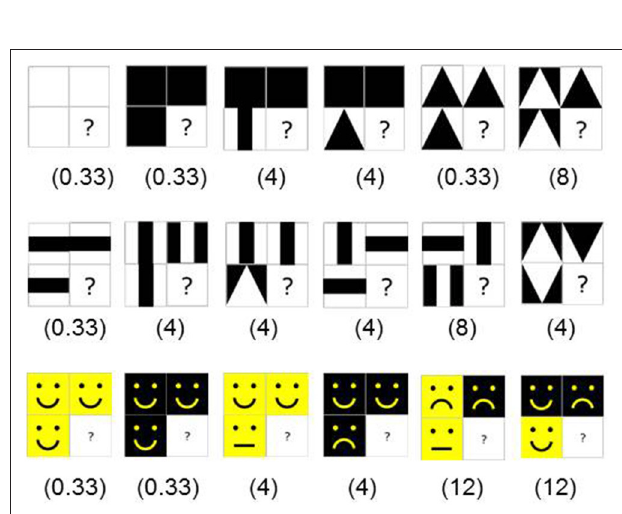
FIGURE 8 | Twelve TAG-Game M -GS items on the first two rows and 6 TAG-Game M -GS items on the third row with corresponding C play S